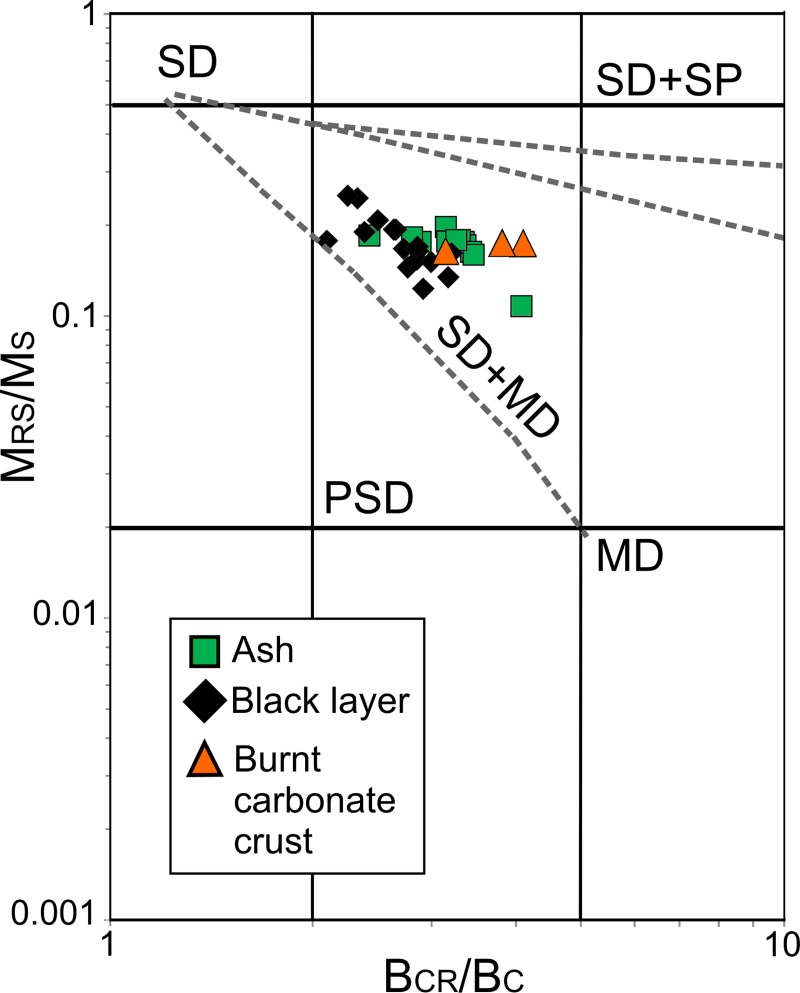
Day plot [85,86] of burnt samples (logarithmic scale).This graphic shows the ratio of saturation remanence (MRS) to saturation magnetization (MS) vs. the ratio of remanent coercive force (BCR) to coercive force (BC). Regions of single domain (SD), pseudo-single domain (PSD) and multi domain (MD) magnetite particles are plotted according to [86], as well as theoretical mixing curves showed as dashed lines including also SP (superparamagnetic) grains.